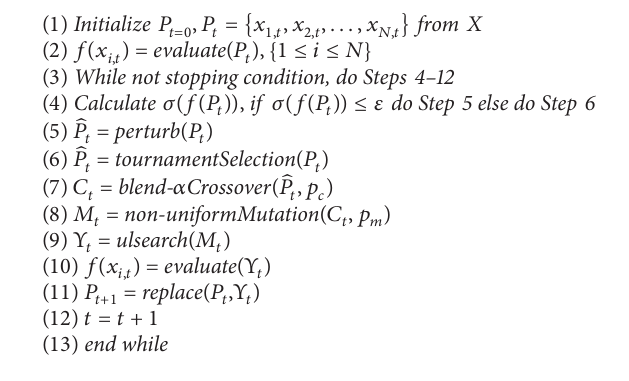
Algorithm 1: The RCGAu